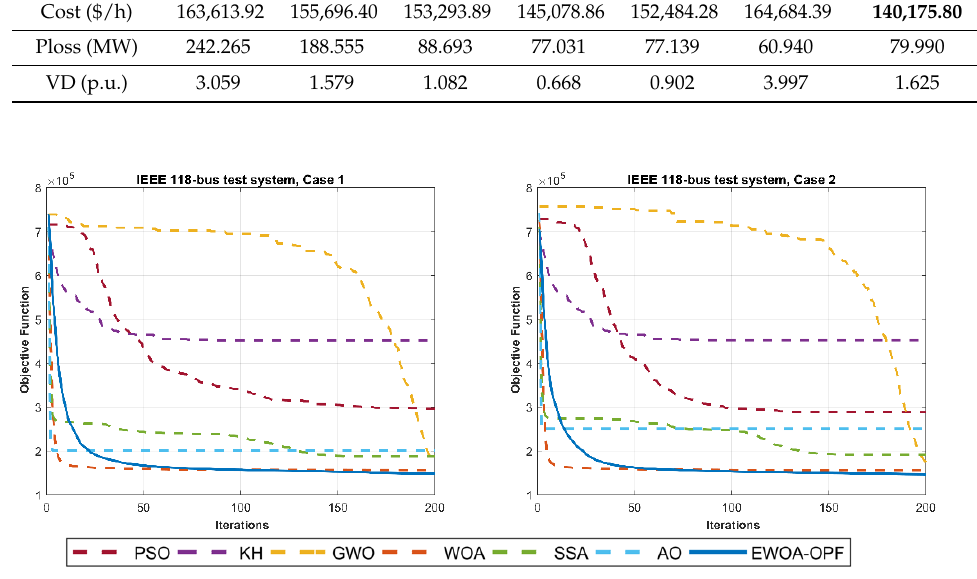
Figure 8. Curves for all test systems on Cases 1 and 2.